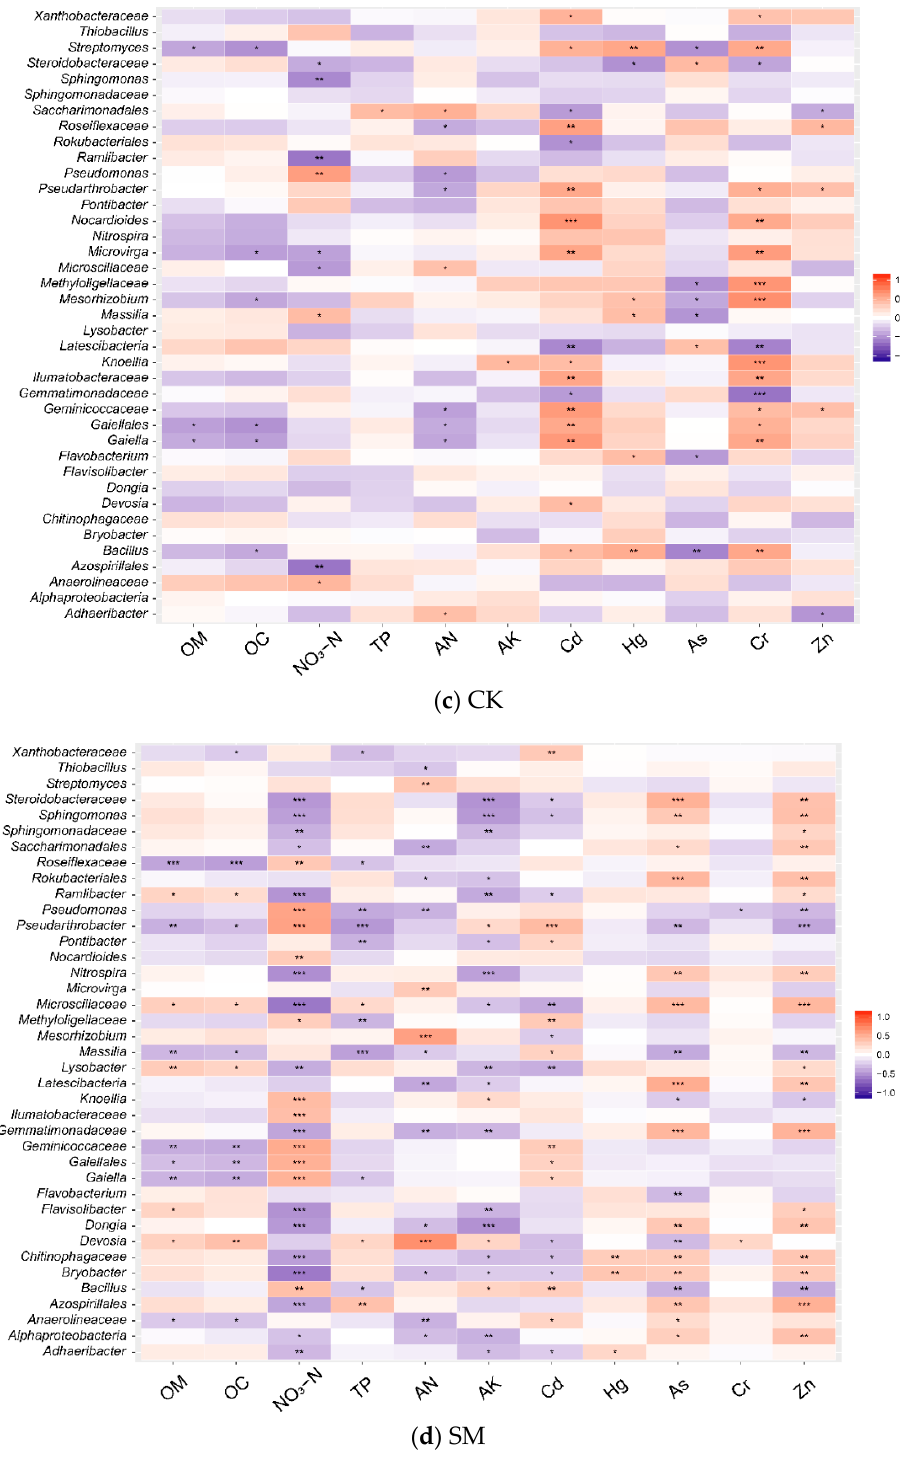
Figure 6. The Pearson correlation analysis of environmental factors and main genus of the CM ( a ), OF ( b ), control ( c ), and SM ( d ) tests (CM: chicken manure; OF: organic fertilizer; OM: organic matter; OC: organic carbon; TP: total phosphorus; AN: available nitrogen; AK: available potassium.* indicateds ( p <0.1), **indicateds ( p <0.05),***indicateds ( p <0.01)).